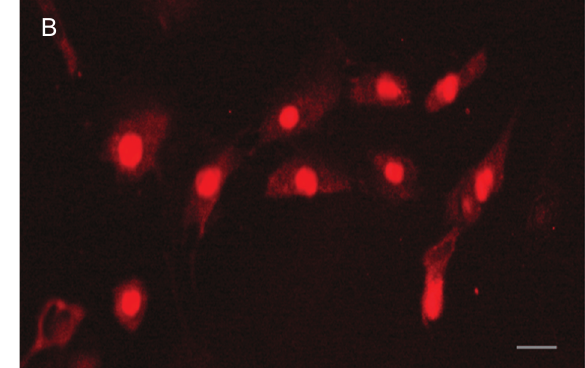
Figure 5. A, NF- κ B normally exists in the cytoplasm in an inac- tive form. B, Ang II treatment increases the translocation of the NF- κ B p65 subunit into the nucleus. C, At 30 min, Ang II-induced NF- κ B activation was the most evident (3.7 ± 0.2, N = 5). DPI and TEL inhibited the activation of NF- κ B induced by Ang II. NF- κ B = nuclear factor-kappa B; DPI = diphenyleneiodonium; TEL = telmisartan. *P < 0.01 vs control group, + P < 0.05 vs Ang II group (Bonferroni test). Original magnification 200X; bars = 50 μ